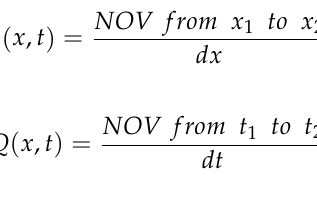
Figure 2. Schematic diagram for fixed road segment RS in a moving traffic.